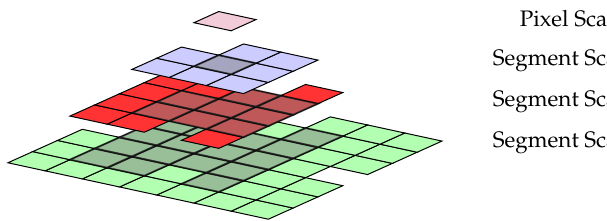
Figure 4. A multiscale superpixel pyramid for feature